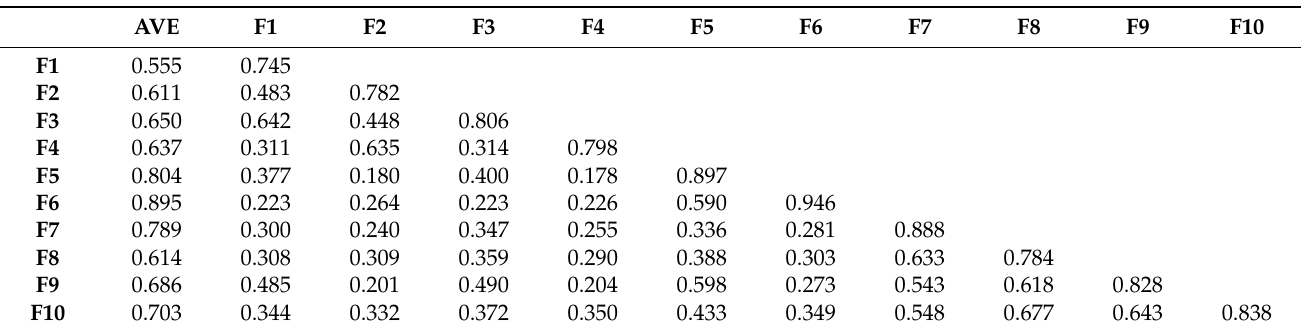
Table 3. Correlations Among All Constructs: Level 1 Model.